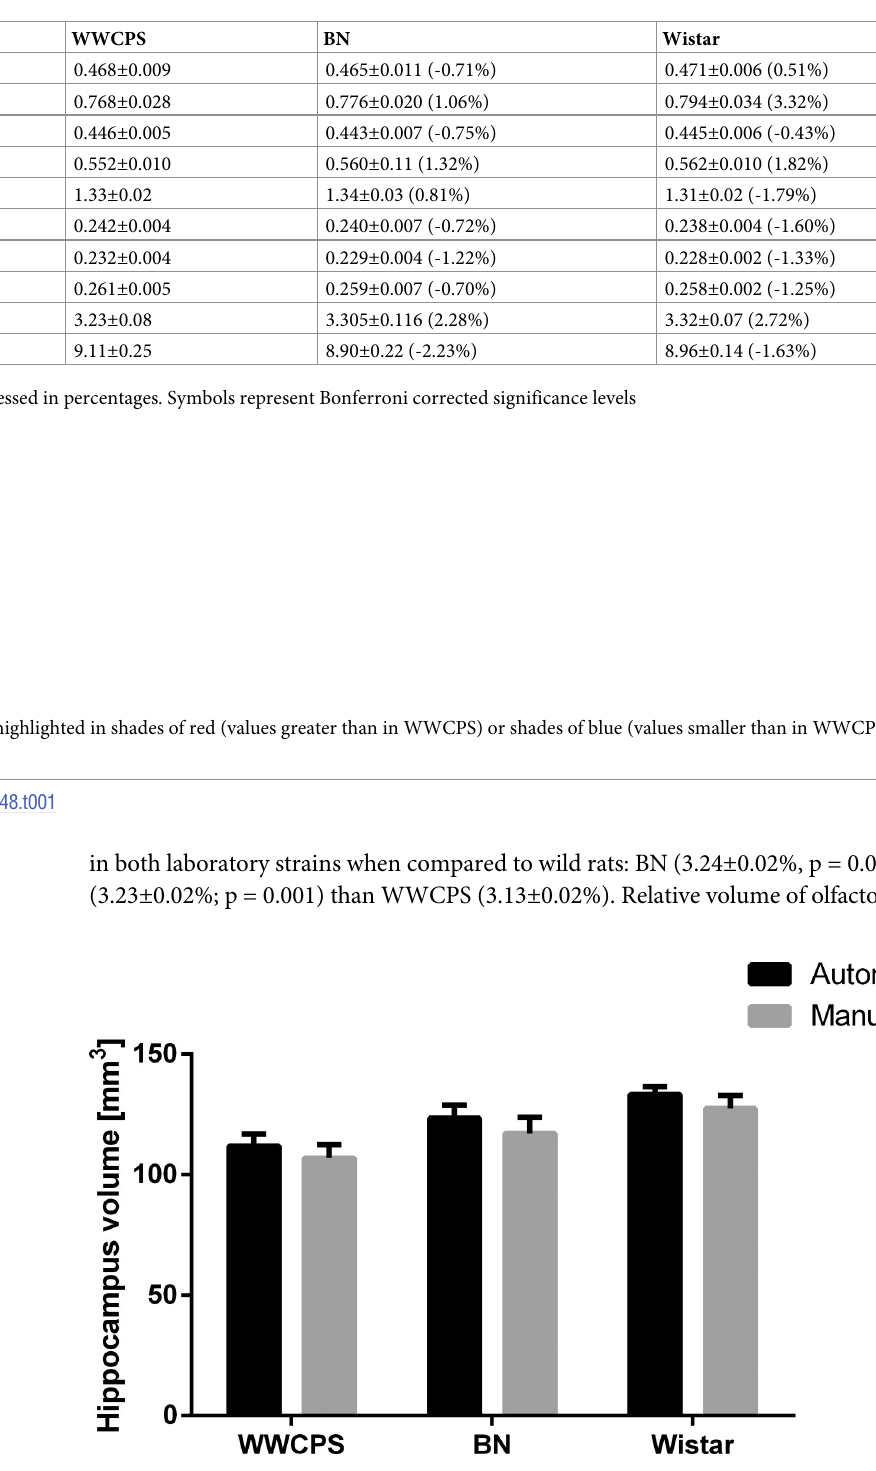
Fig 4. Segmentation validation. Results of automated segmentation (black bars) was compared with manual segmentation of the hippocampi (grey bars) for all the individuals included in the study. The graph presents non- normalized data. Means ±